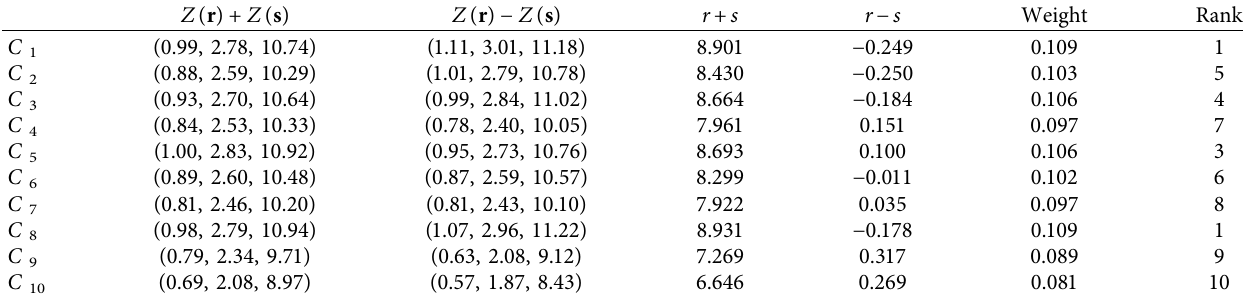
Table 6: Z -DEMATEL